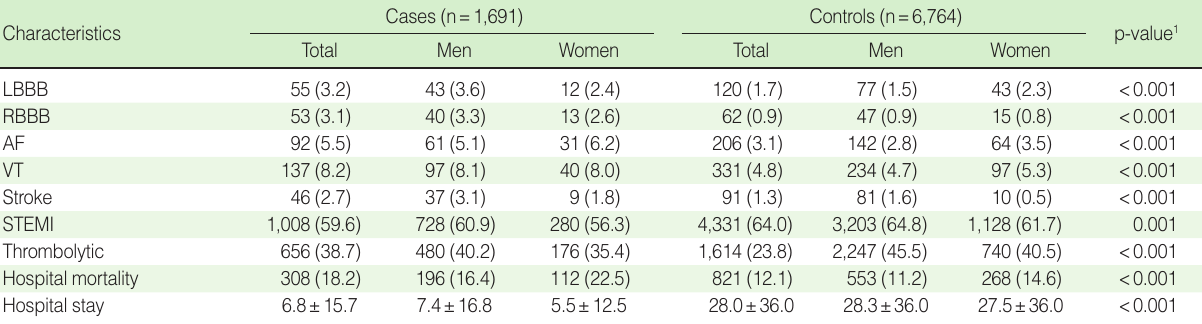
Table 2. Comparison of the clinical factors and co-morbidity at baseline (the date at heart failure diagnosis) in cases and controls, adjusted for gender